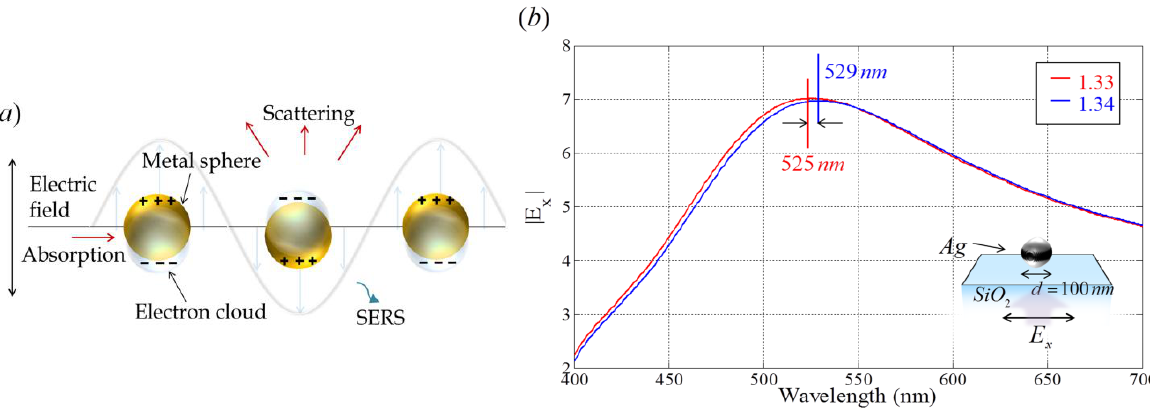
Figure 6. (a) Concept of localized surface plasmon resonance; and (b) spectrum of an enhanced amplitude of E field from an Ag nanoparticle on a SiO x refractive index of the surrounding medium is changed from 1.33 to 1.34 RIU. The Ag nanoparticles have a diameter of 100